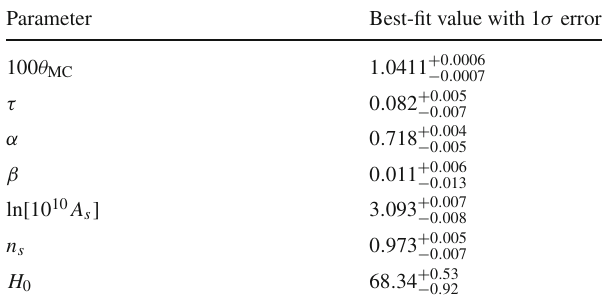
Table 2 The best-fit values and 1 σ errors of different parameters